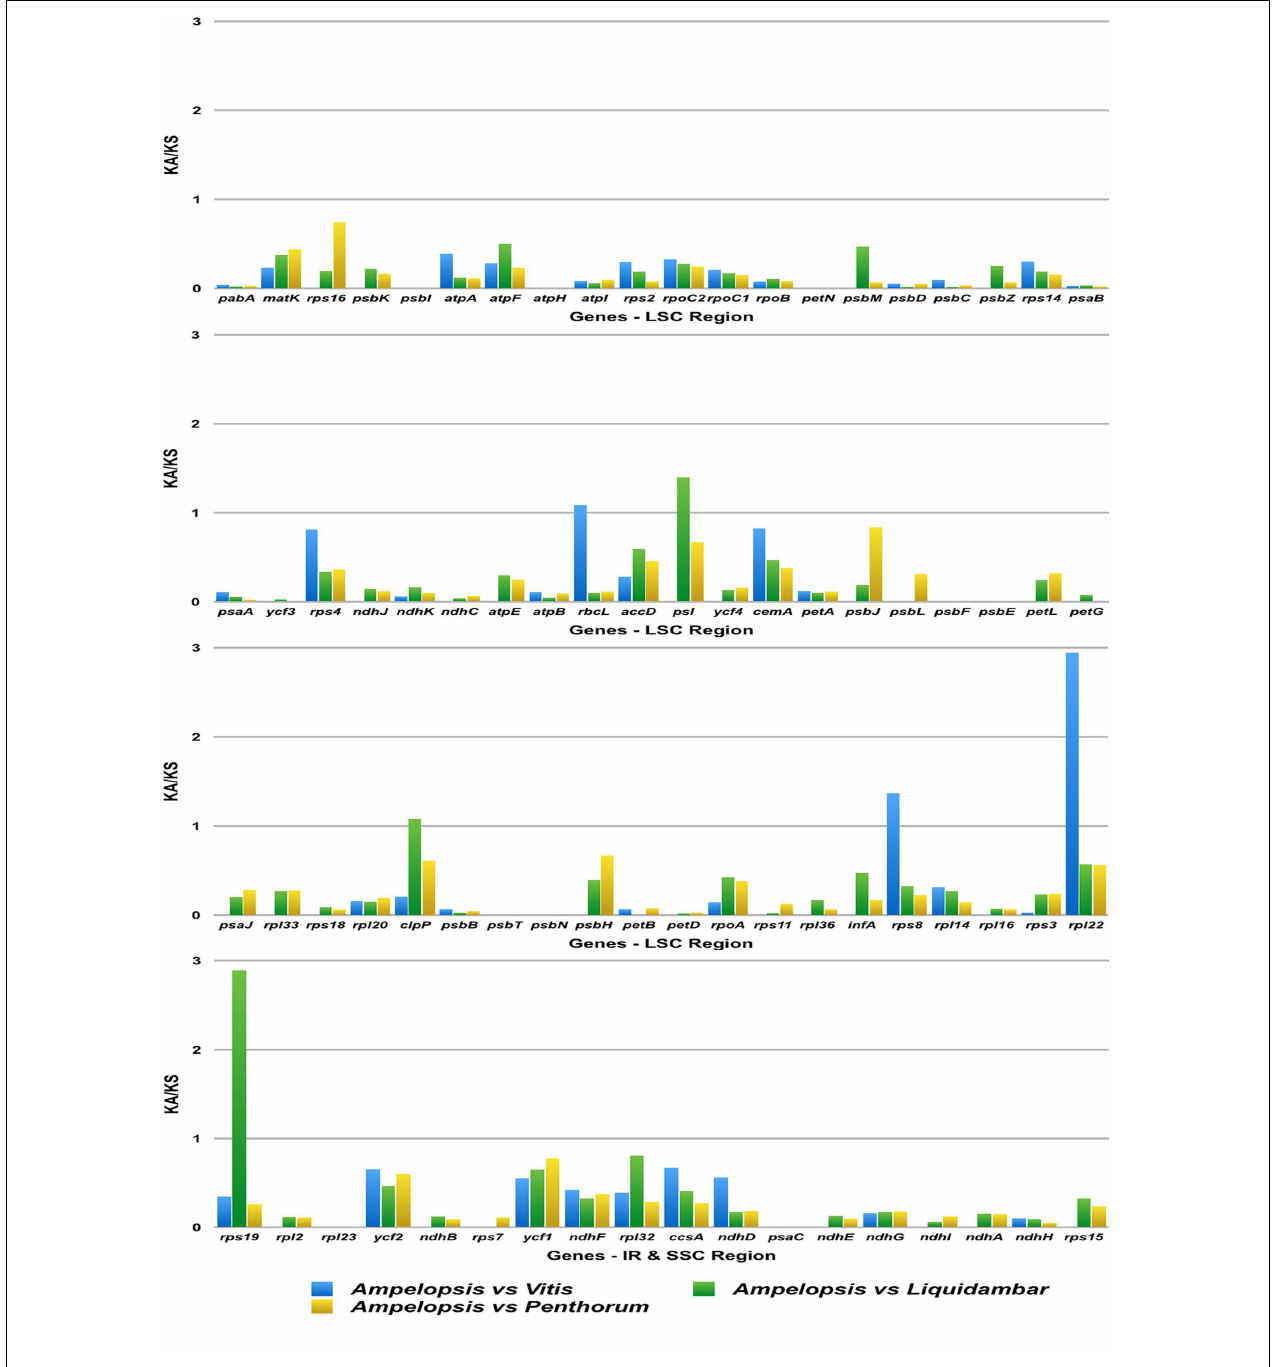
FIGURE 5 | K A /K S values of 78 protein-coding genes of Ampelopsis brevipedunculata , Vitis vinfera , Liquidambar formosana, and Penthorum chinense . Blue color boxes indicate the K A /K S ratio of the A. brevipedunculata vs. V . vinfera , Green color boxes indicate A. brevipedunculata vs. L . formosana and Yellow color boxes indicate A. brevipedunculata vs. P . chinense